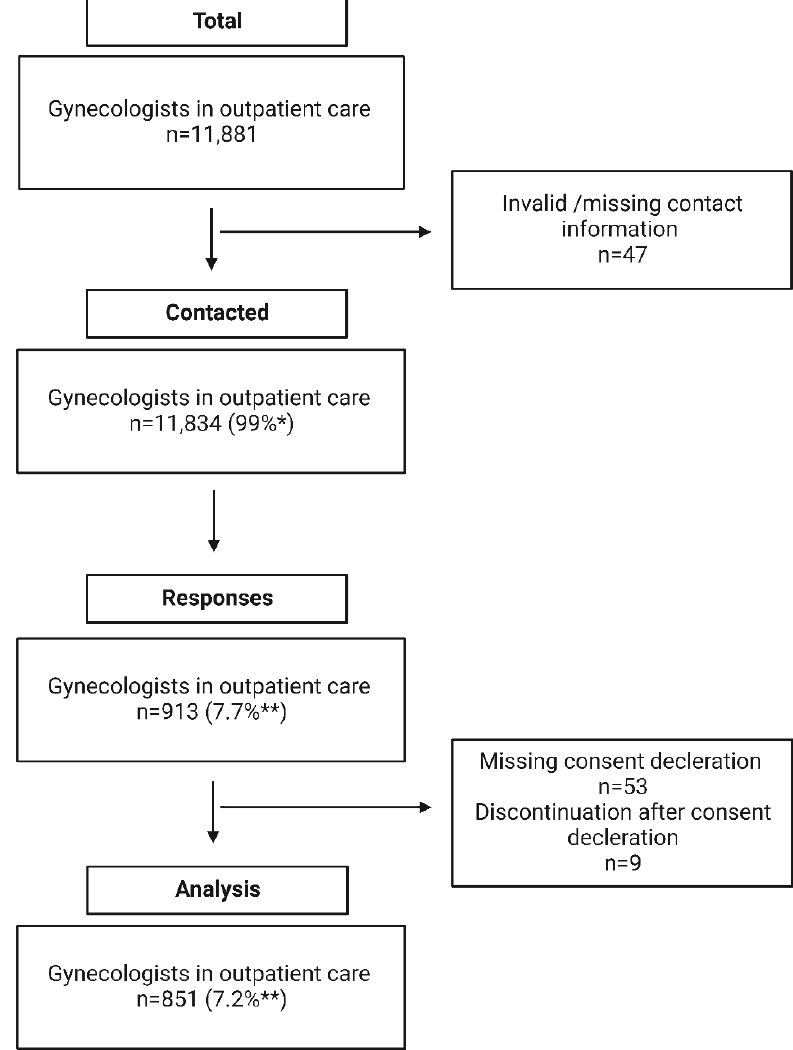
Figure 1. Recruitment; * percent of total population, ** percent of contacted gynecologists.